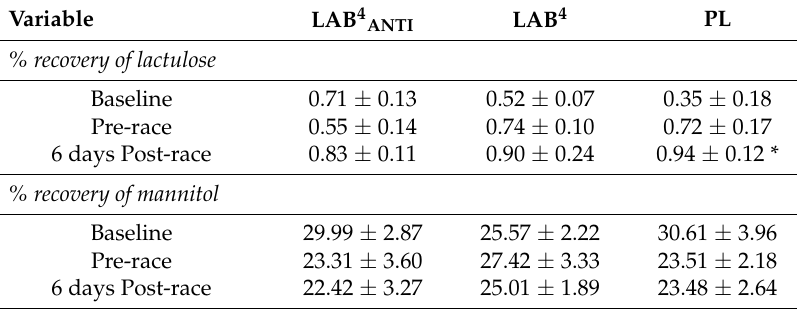
Table 4. Recovery of urinary lactulose and mannitol (%).